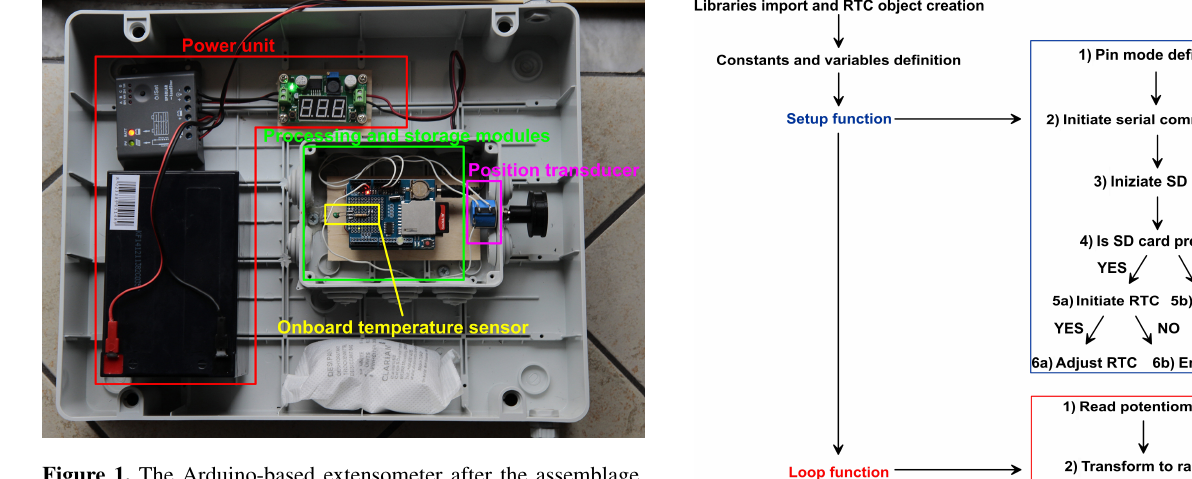
Figure 1. The Arduino-based extensometer after the assemblage. Major electronic components are labeled.